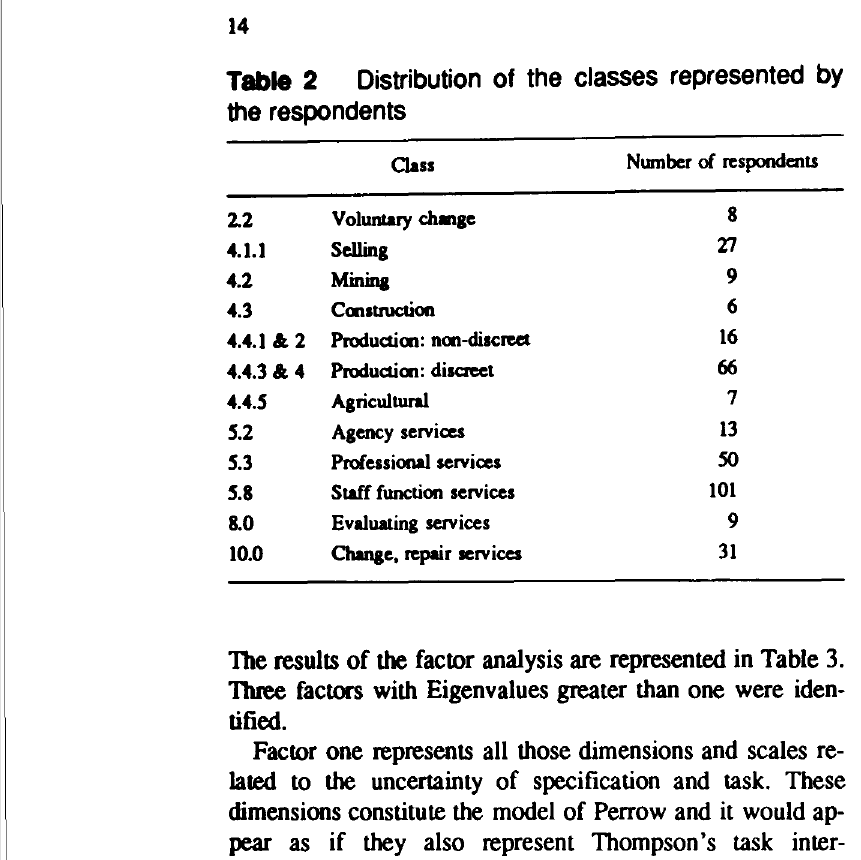
Results of the principle factor